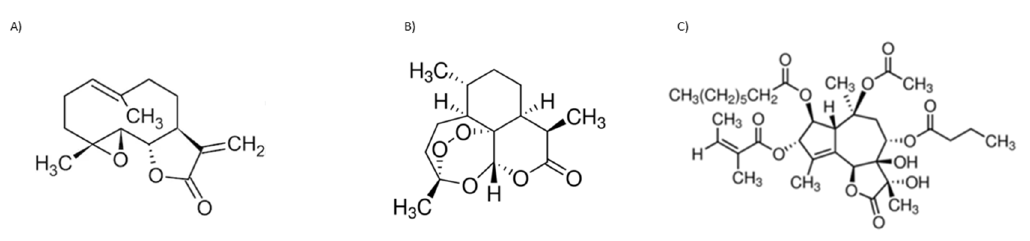
Figure 4. Sesquiterpene chemical structures: ( A ) parthenolide, ( B ) artemisinin, and ( C ) thapsigargin. Parthenolide has low solubility in water and, consequently, reduced bioavailability, which hampers its potential clinical use. A Phase I trial was conducted to investigate phar- macokinetics and toxicology in a cohort of 12 adult cancer patients. Solid phase extraction and mass spectroscopy were used to evaluate parthenolide plasma concentrations.